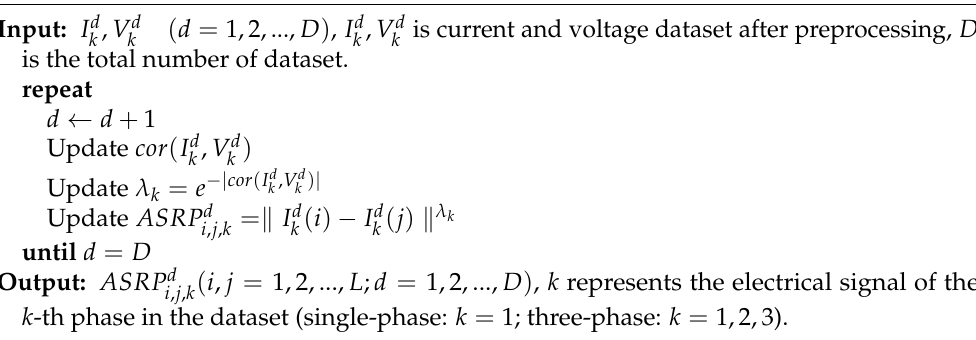
Algorithm 1 Load feature extraction based on